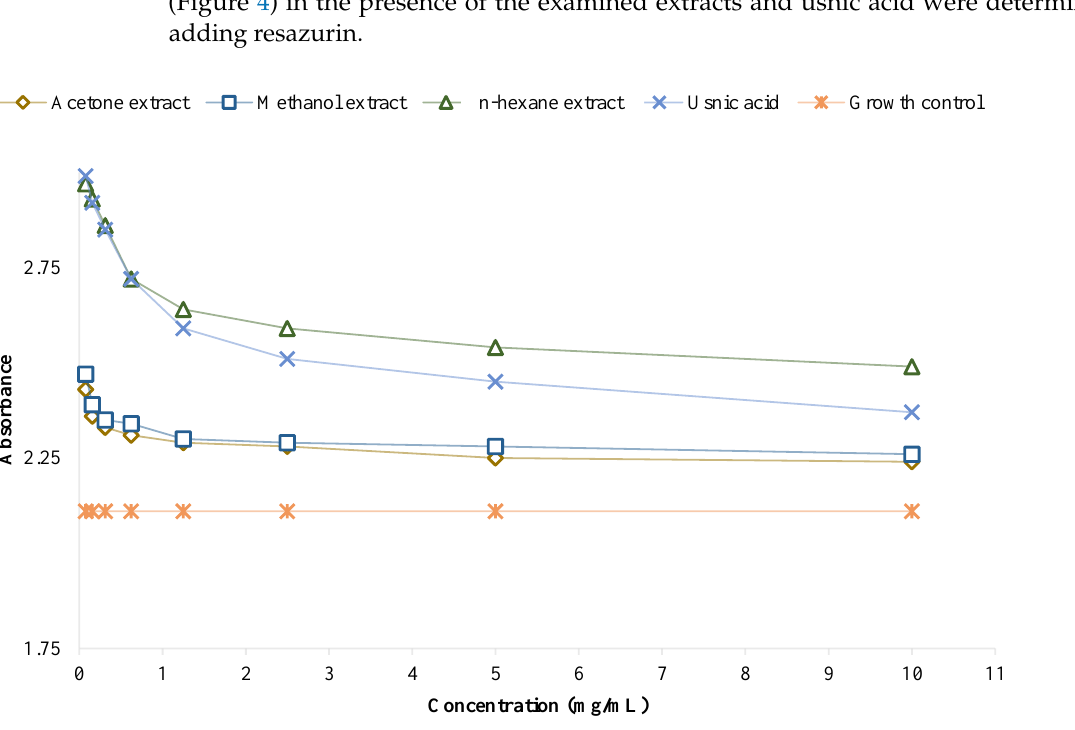
Figure 4. The impact of the tested extracts and usnic acid on the metabolic activity of S. aureus ATCC 6538 biofilm. The biofilm mass and metabolic activity results were correlated, i.e., an increase in biofilm mass productivity corresponded to increased biofilm metabolic activity. Briefly,